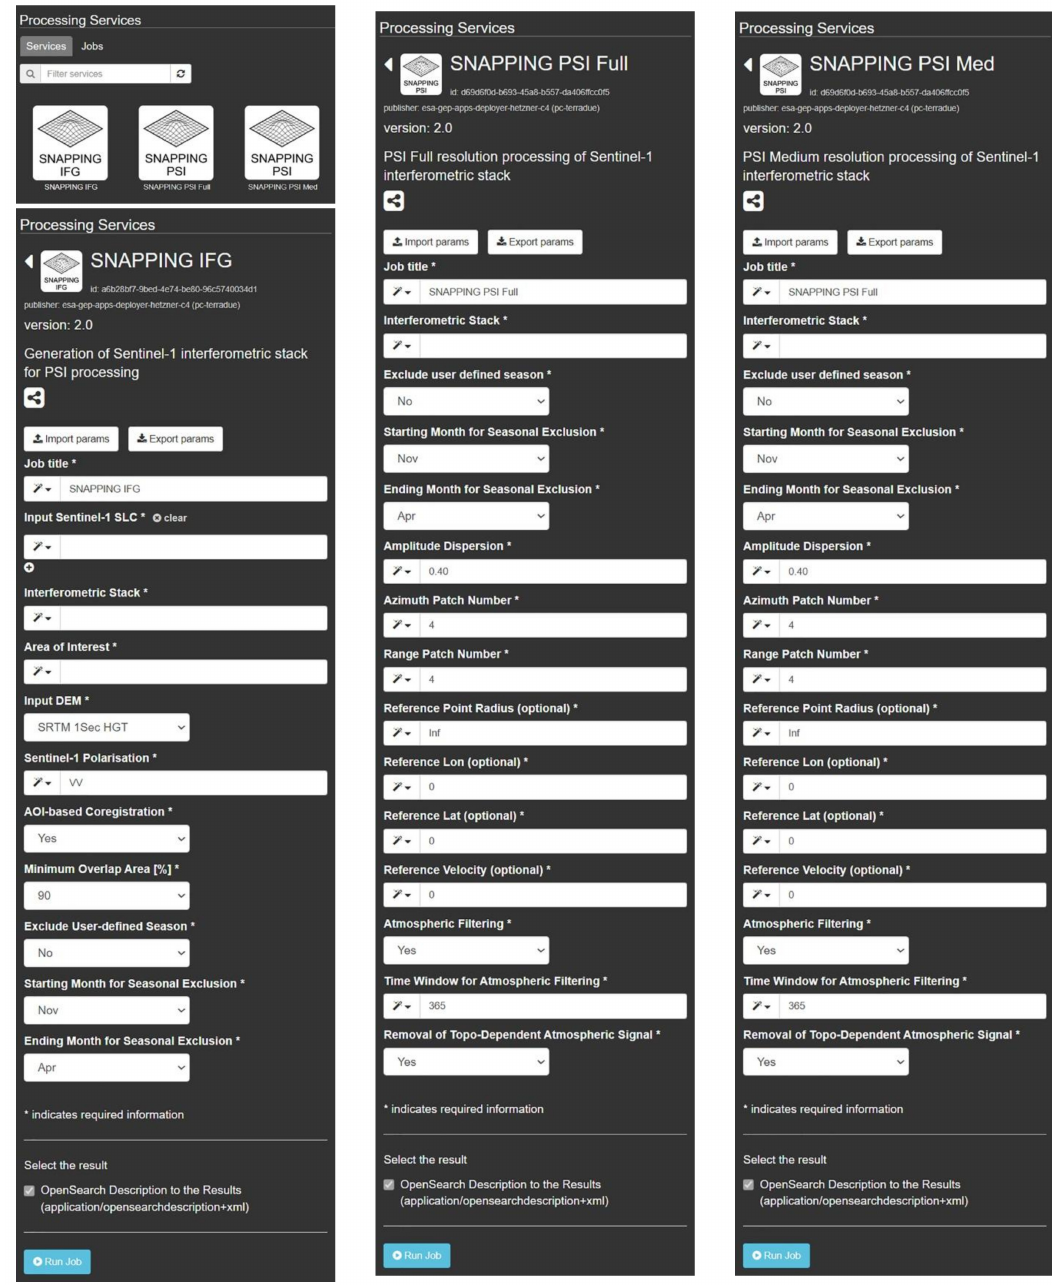
Figure 5. User interfaces of SNAPPING IFG and PSI (Med and Full resolution) services on GEP, including default processing parameters. The interfaces refer to version 2.0 of the services released in July